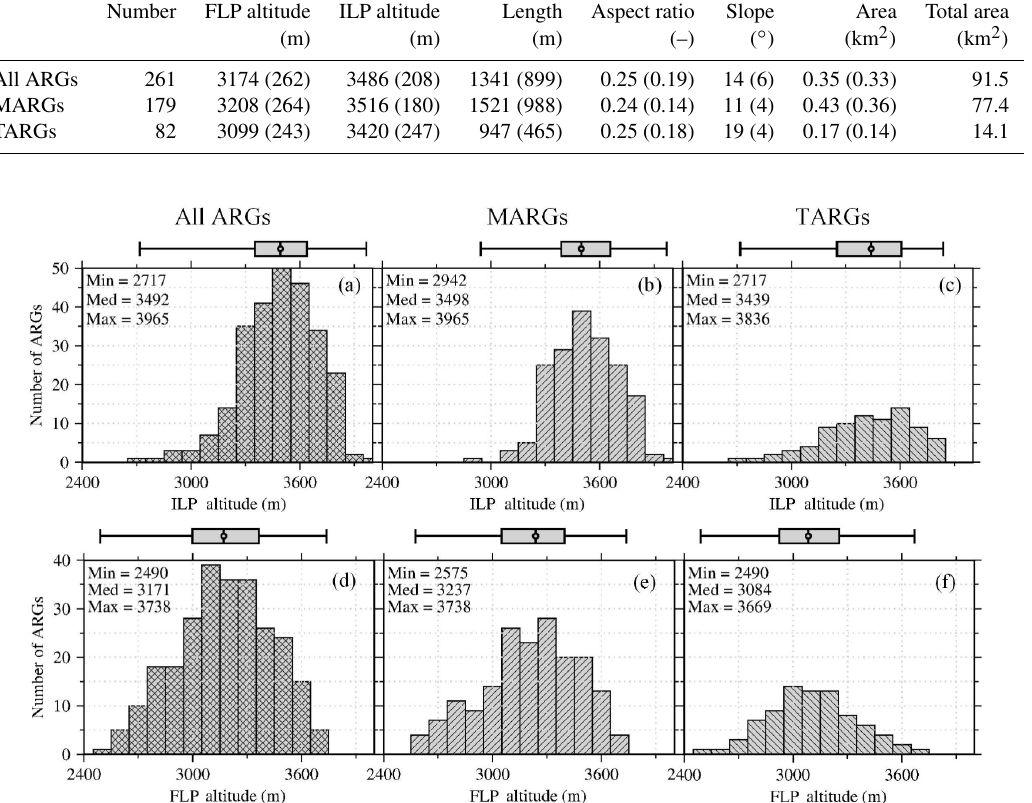
Figure 5. Histograms of the ILP altitudes (a–c) and FLP altitudes (d–f) for all ARGs, MARGs, and TARGs, respectively. The minimum (Min), median (Med), and maximum (Max) values for the ILP altitudes and FLP altitudes are denoted. Their units are meters. The box on the top of each subfigure denotes the box-and-whisker symbol, which gives the locations of the minimum, the 25% quantile, the 50% quantile, the 75% quantile, and the maximum values. The altitudes are derived from the SRTM digital elevation model